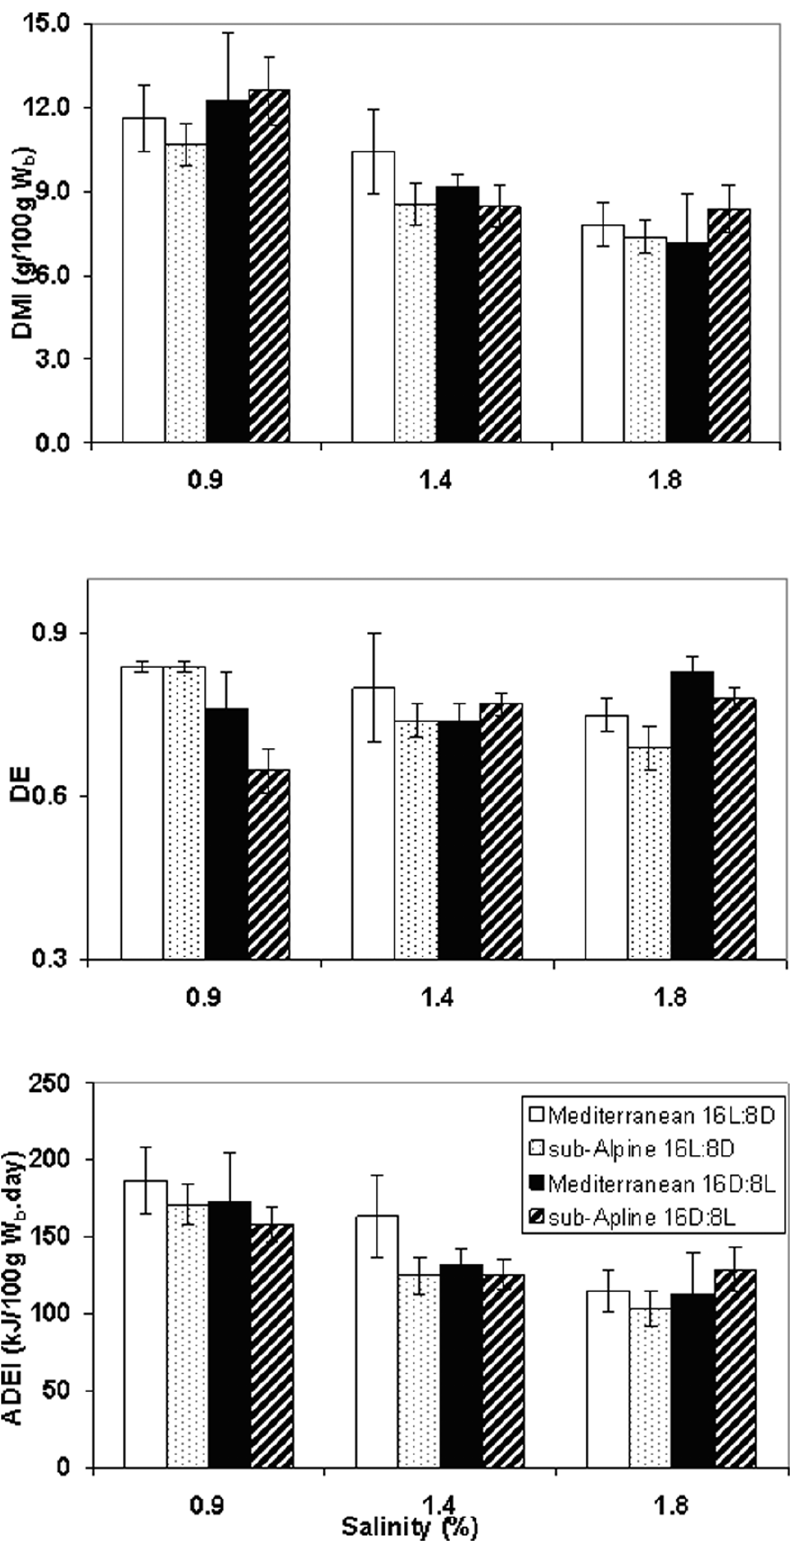
Figure 1. Digestibility Experiments. ( A ) Dry matter intake ( DMI : g/100 g W b .day); ( B ) Digestible efficiency ( DE ) and ( C ) apparent digestible energy intake ( ADEI : kJ/100 g W b .day) of A. mystacinus at salinity regimes of 0.9, 1.4 and 1.8%. Open and dotted bars denote long-day (16L:8D) Mediterranean and sub-Alpine mice; dark bars and hashed bars denote short-day (16D:8L) Mediterranean and sub-Alpine mice, respectively. ‘‘/100 g W b .day’’ denotes per 100 g body mass per day. Error bars denote standard errors.